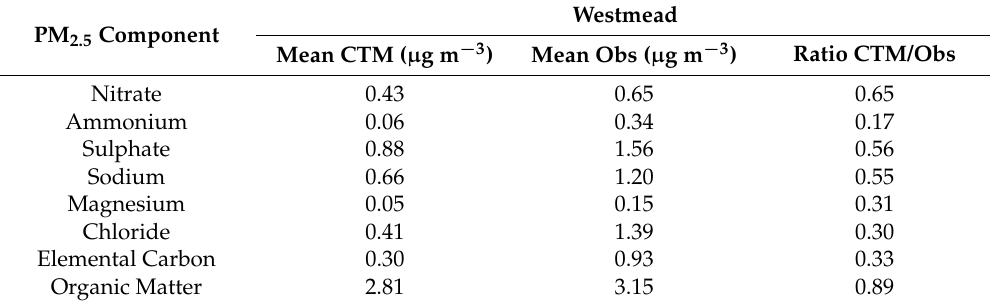
Figure 16. Modelled and observed average concentrations of PM2.5 species at Westmead for SPS1. Table 5. Comparison of modelled and measured average concentrations of PM 2.5 speciated components measured at Westmead during SPS1.